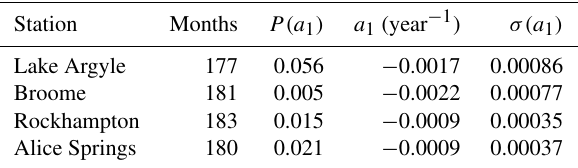
Table 3. Analysis of linear trends a 1 expressed as the change in aerosol optical depth per year. Only stations with at least a 10-year data record and trend significance of P(a 1 ) ≤ 6% are listed. σ(a 1 ) is the standard uncertainty in a 1